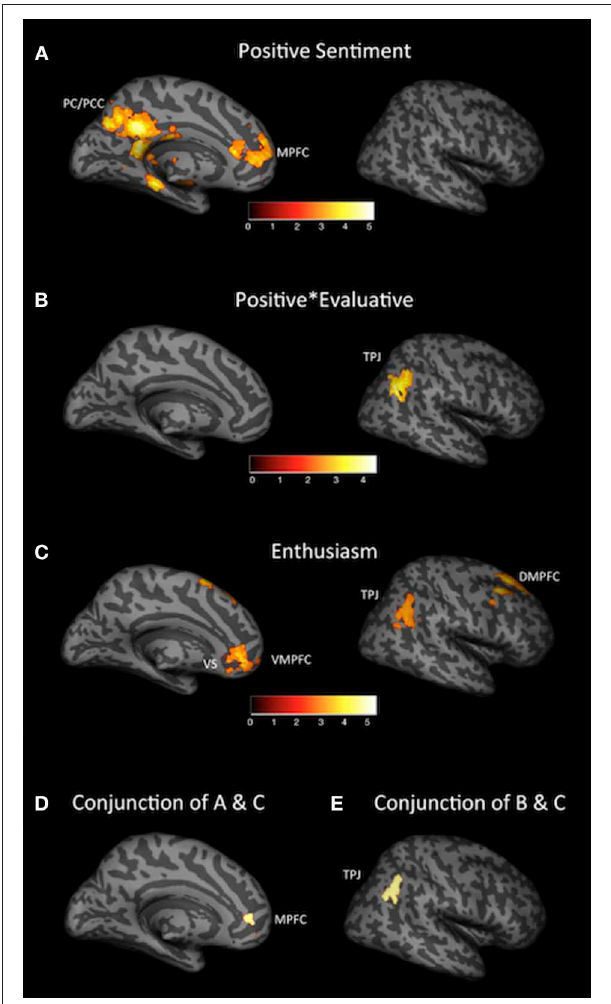
FIGURE 2 | Neural regions associated with the ways in which ideas were communicated after the scan. (A) Associations with positive